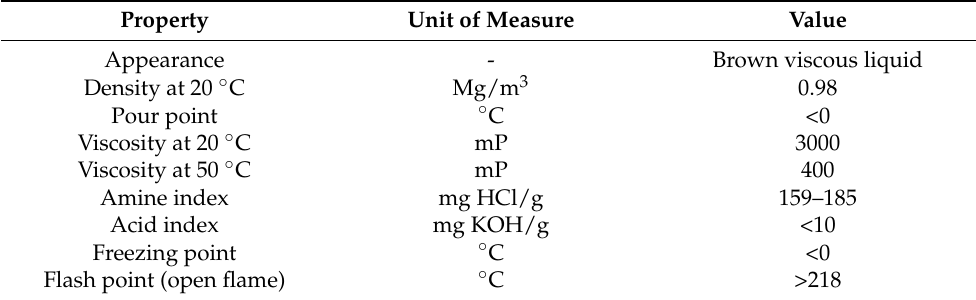
Table 3. Characteristics of the surface-active agent (SAA)